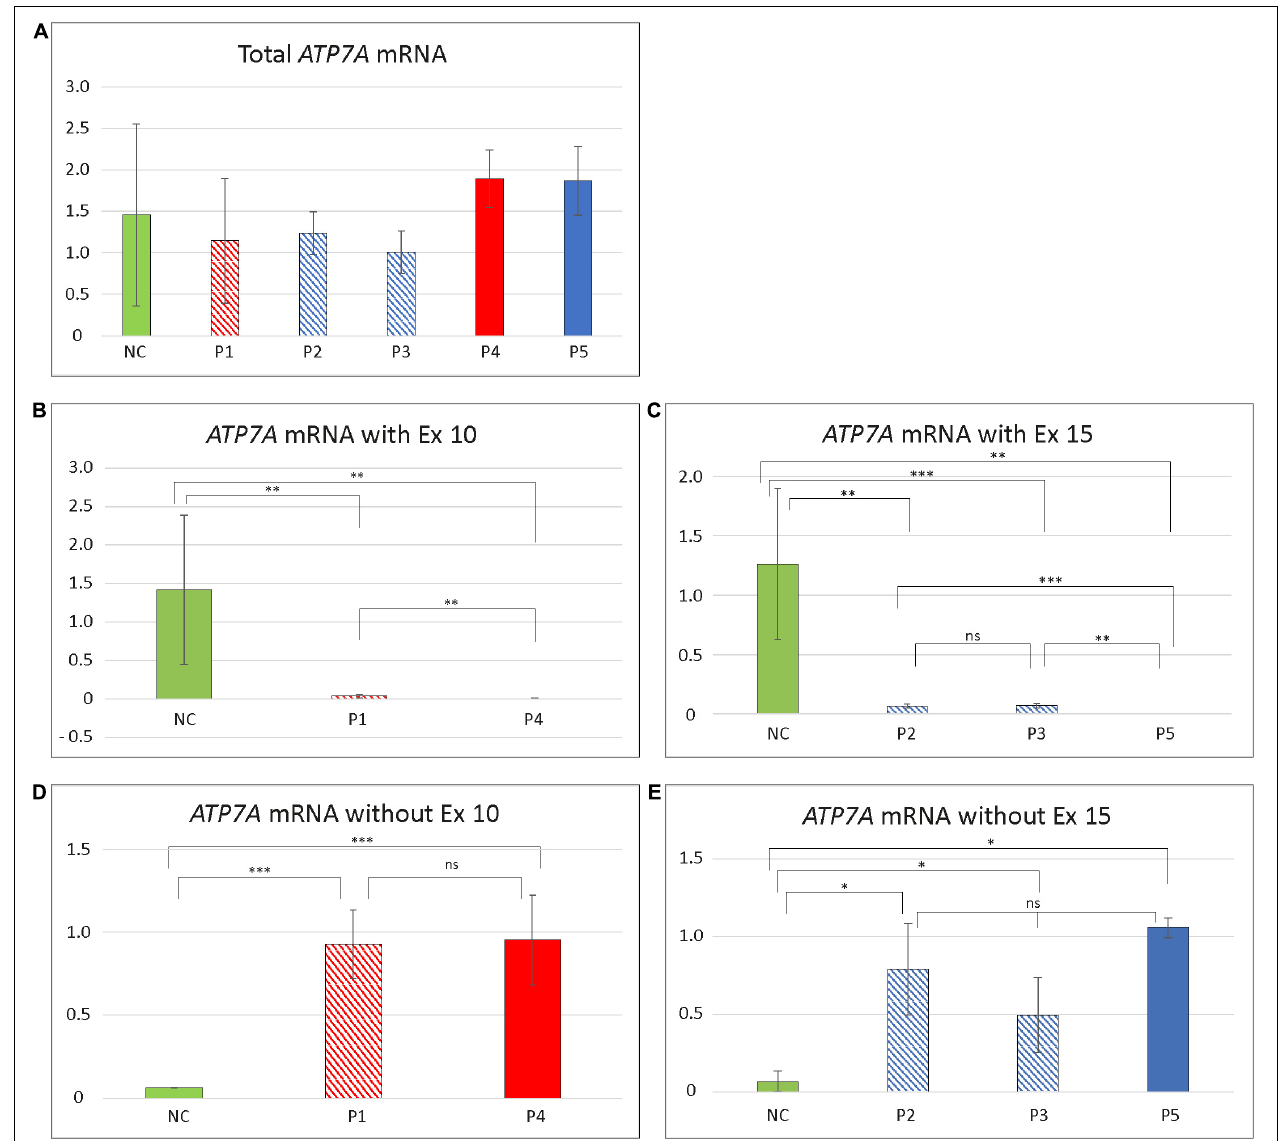
FIGURE 4 | Relative amount of different ATP7A transcript in patient fibroblasts. (A) Total amount of transcript in the five patients compared to controls. No significant difference in amount in any of the patients compared with controls (NC) was identified (P1/NC: p = 0.4884; P2/NC: p = 0.4926; P3/NC: p = 0.2703; P4/NC: p = 0.4156; P5/NC: p = 0.5293). (B) Total amount of exon 10 (Ex10) containing transcript in P1 and P4. The amount of Ex10 containing transcript was significantly reduced compared to controls in both patients (P1/NC: p = 0.0026; P4/NC: p = 0.0011). Furthermore, the amount of transcript was significantly higher in P1 compared with P4 ( p = 0.0030). (C) Total amount of exon 15 (Ex15) containing transcript in P2, P3, and P5. All patients had significantly reduced amount of Ex15 containing transcript compared with controls (P2/NC: p = 0.0038; P3/NC: p = 0.00025; P5/NC: p = 0.0029). The amount of Ex15 containing transcript was significantly higher in P2 ( p = 0.0040) and P3 ( p = 0.00065) compared with P5. No significant difference in amount was obtained between P2 and P3 ( p = 0.6845). (D) Amount of ATP7A mRNA without Ex10. The amount of transcript without Ex10 were significantly increased in P1 and P4 compared with controls (P1/NC: p = 3.57 × 10 - 8 ; P4/NC: p = 0.00034). No significant difference in amount was observed between P1 and P4 ( p = 0.9170). (E) Amount of ATP7A mRNA without Ex15. The amount of transcript without Ex15 was significantly increased in P2, P3, and P5 compared with controls (P2/NC: p = 0.0107; P3/NC: p = 0.0210; P5/NC: p = 0.0430). No significant difference in amount was observed between P2, P3, and P5 (P2/P3: p = 0.1525; P2/P5: p = 0.6819; P3/P5: p = 0.2821). The relative amounts of ATP7A mRNA in (A–C) are calculated by linear regression of lines generated by standard curves and (D,E) calculated using the (cid:49)(cid:49) CT method. The amount of GAPDH transcript was used as a normalization reference. Data obtained for P4 in (D) and P2 in (E) were pooled from two independent mRNA isolations; for all the additional experiments, data were pooled from at least three independent mRNA isolations. In all experiments, at least three different control samples were used. Student t -test, with significance level * p < 0.05, ** p < 0.005, and *** p < 0.0005, was used. Error bars represent SEM ( n = 2–3). NC values are illustrated as green columns. Values for variants affecting splicing of exon 10 are illustrated as shaded red (P1 with OHS) and full red (P4 with MD) columns. Values affecting splicing of exon 15 are illustrated as shaded blue (P2 and P3 with OHS) and full blue (P5 with MD) columns.